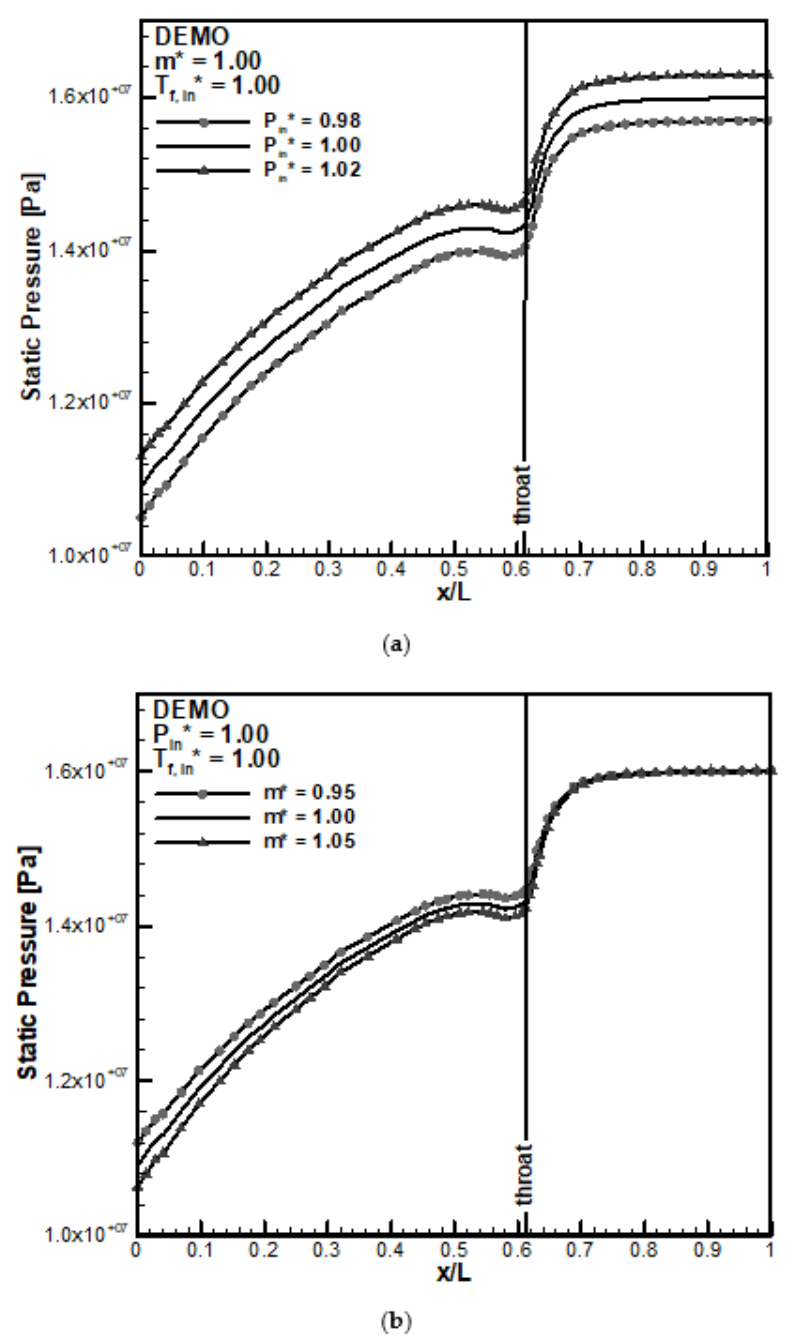
Figure 19. Axial profiles of static pressure (runs 1, 5-8): ( a ) effects of inlet pressure; ( b ) effects of mass flow rate.